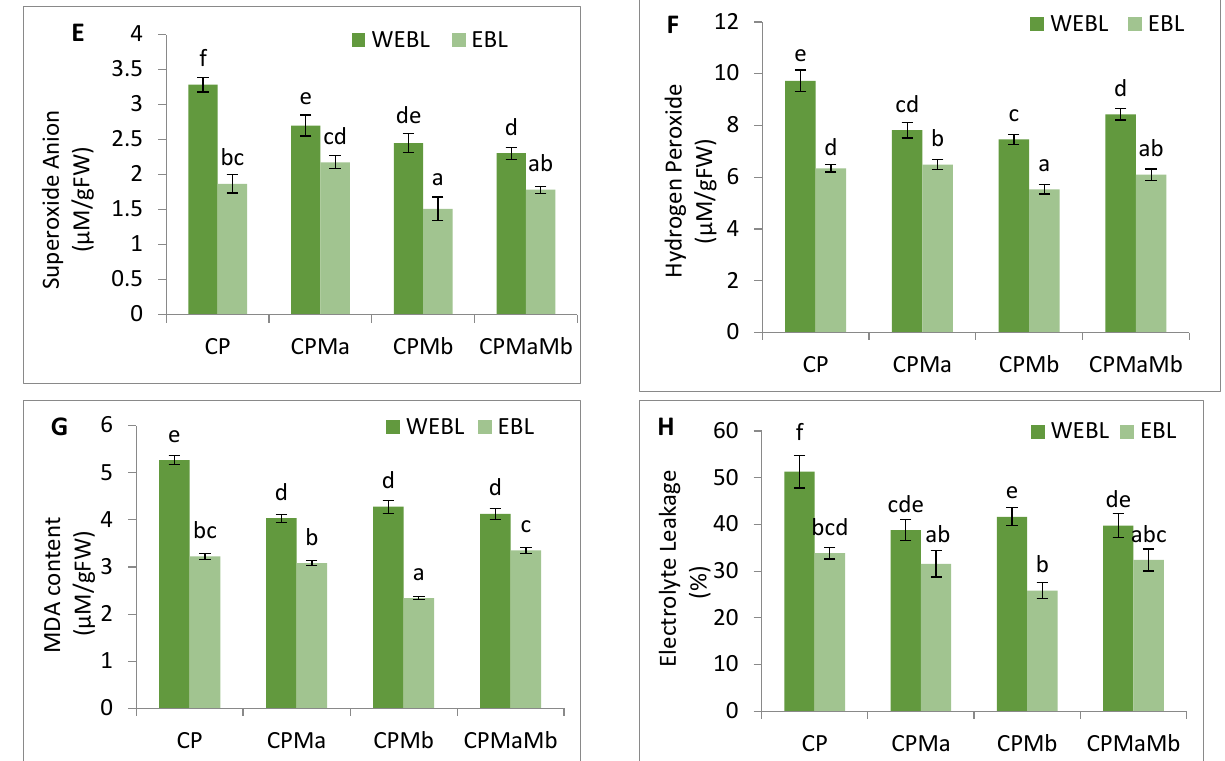
Figure 1. Effect of seed priming with 100 nM of 24-epibrassinolide (EBL) and plant-growth-promoting rhizobacteria ( Pseudomonas aeruginosa (Ma, 10 9 cells/mL) and Burkholderia gladioli (Mb, 10 9 cells/mL)) on ( A ) germination potential (%), ( B ) hypocotyl length ( C ) radicle length, ( D ) vigour index (%), ( E ) superoxide anion, ( F ) hydrogen peroxide, ( G ) MDA content and ( H ) EL content of 10-day-old B. juncea L. seedlings under chlorpyrifos (CP) toxicity. Data are presented as mean of three replicates ± s.d. (standard deviation). Means were compared using two-way analysis of variance followed by Tukey’s post-hoc test ( p < 0.05). Different superscripts indicate significant difference between the treatments. (Note: WEBL = without 24-epibrassinolide , EBL = 24- epibrassinolide ).